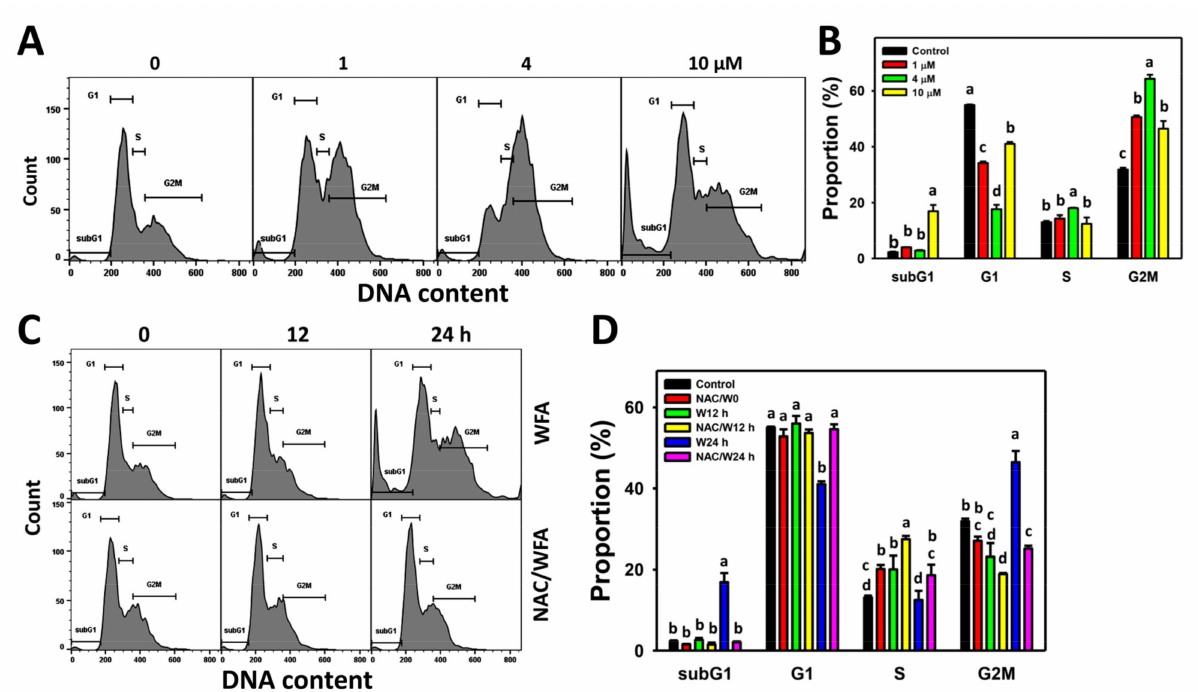
Figure 2. Cell cycle effect of WFA in bladder cancer cells. ( A , B ) Patterns and statistics for the cell cycle. Bladder cancer cells (J82) were treated with WFA (24 h, 0 to 10 µ M), where the negative control for WFA (0 µ M) contained 0.1% DMSO. ( C , D ) Pattern and statistics for NAC pretreated effects on the cell cycle of J82 cells following WFA incubation. Cells were pretreated and post treated with NAC (8 mM, 1 h) and WFA (0 and 10 µ M for 12 and 24 h), respectively. They were labeled with NAC/W0, NAC/W12 h, and NAC/W24 h. Data, mean ± SD ( n = 3). Columns showing non-overlapping lower-case letters, indicating p < 0.05 for multiple comparisons of the same cell cycle phase. In the example of subG1 in Figure 2D, the W24 h treatment shows “a” while others show “b”, indicating that W24 h significantly differed from others. Among non-W24 h treatments, their labeling letters are overlapping with “b”. Therefore, it shows nonsignificant differences between each